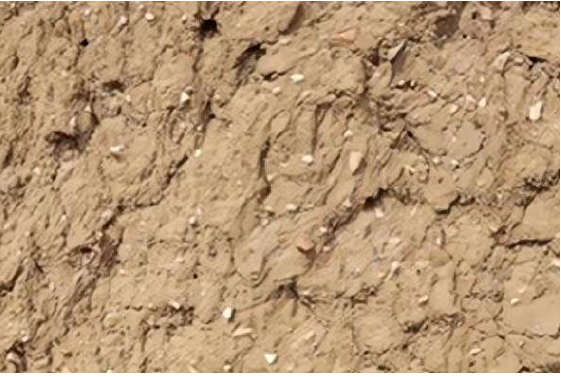
Figure 22. The rammed earth